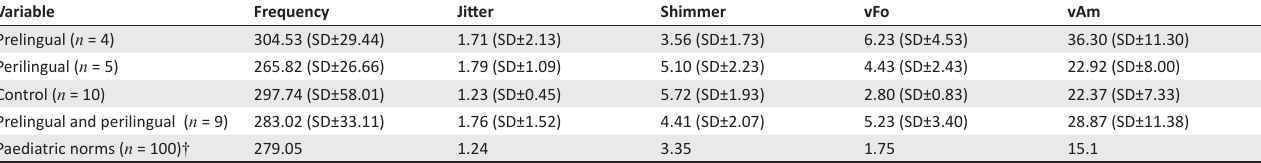
TABLE 2: Acoustic outcomes of cochlear implantation users (prelingual and perilingual), the controls and the paediatric norms for vocal parameters.